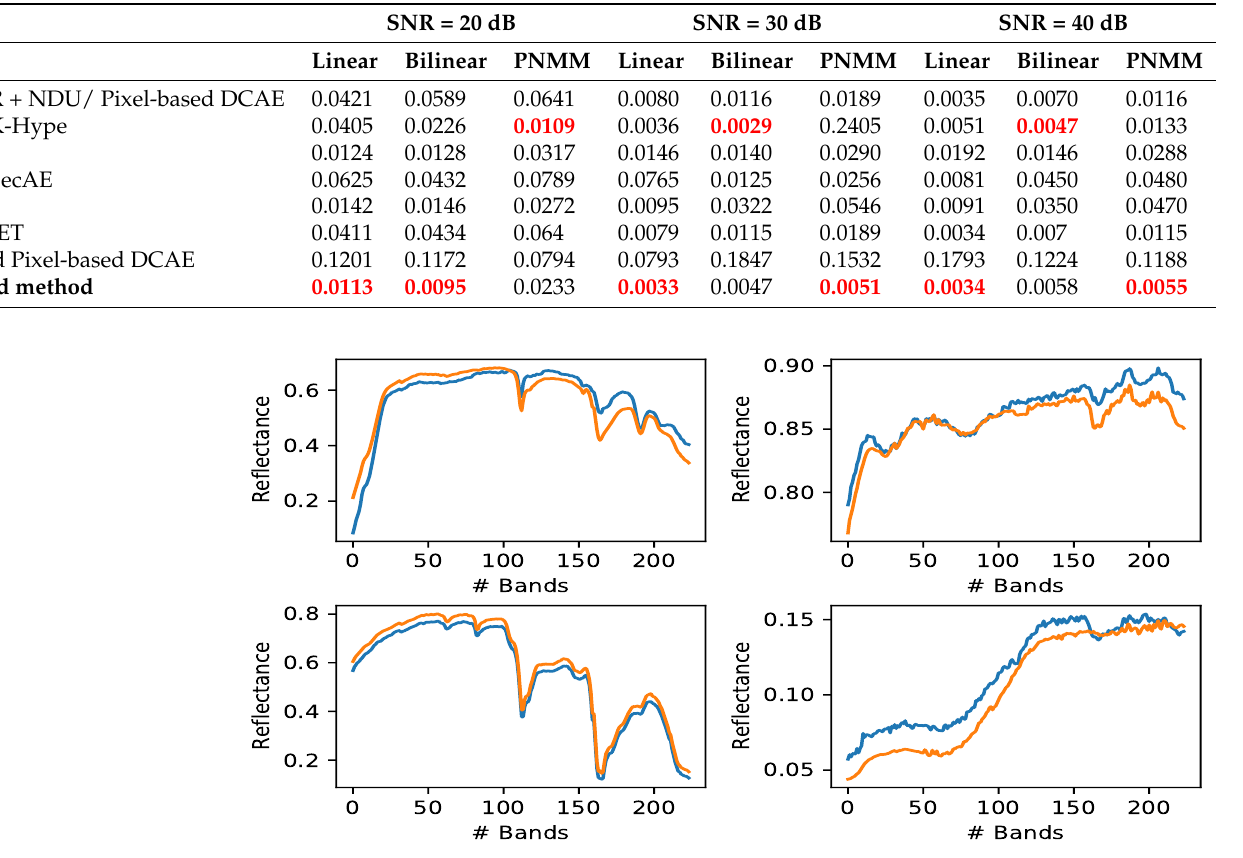
Figure 4. Comparison between extracted endmembers and the four ground truth synthetic endmem- bers. Orange curves: true endmembers; Blue curves: extracted endmembers (SNR = 20 dB, bilinear model